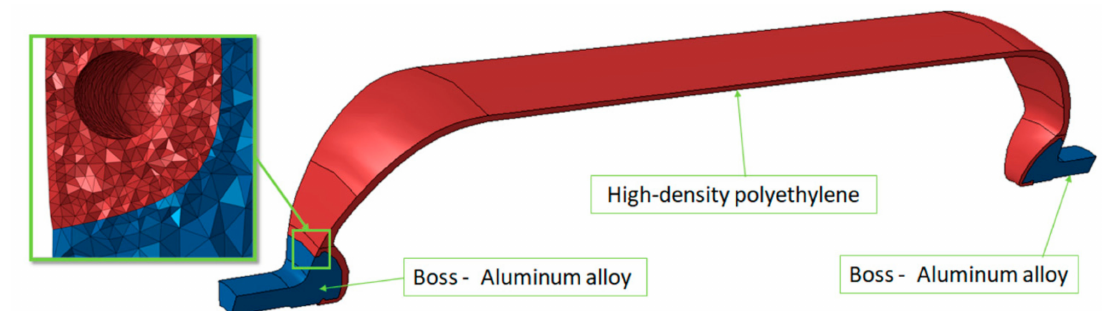
Figure 9. Liner model used in FEA with zoomed mesh around the